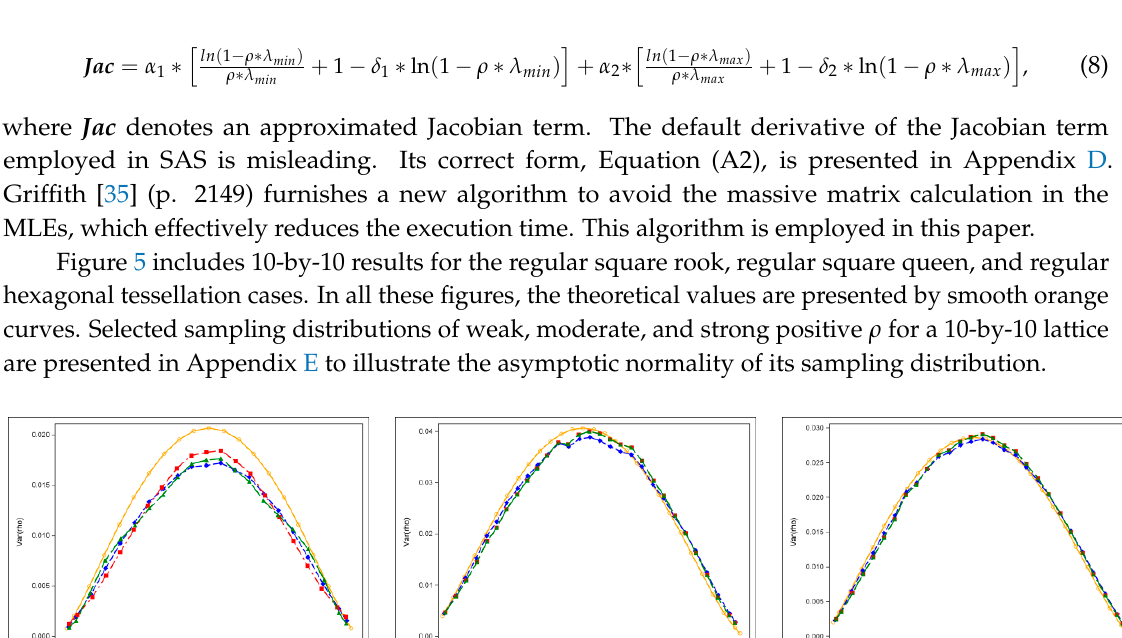
Table 4. Methods employed with a 10-by-10 lattice *.